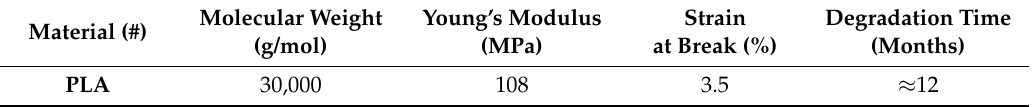
Table 5. Poly (lactic acid)